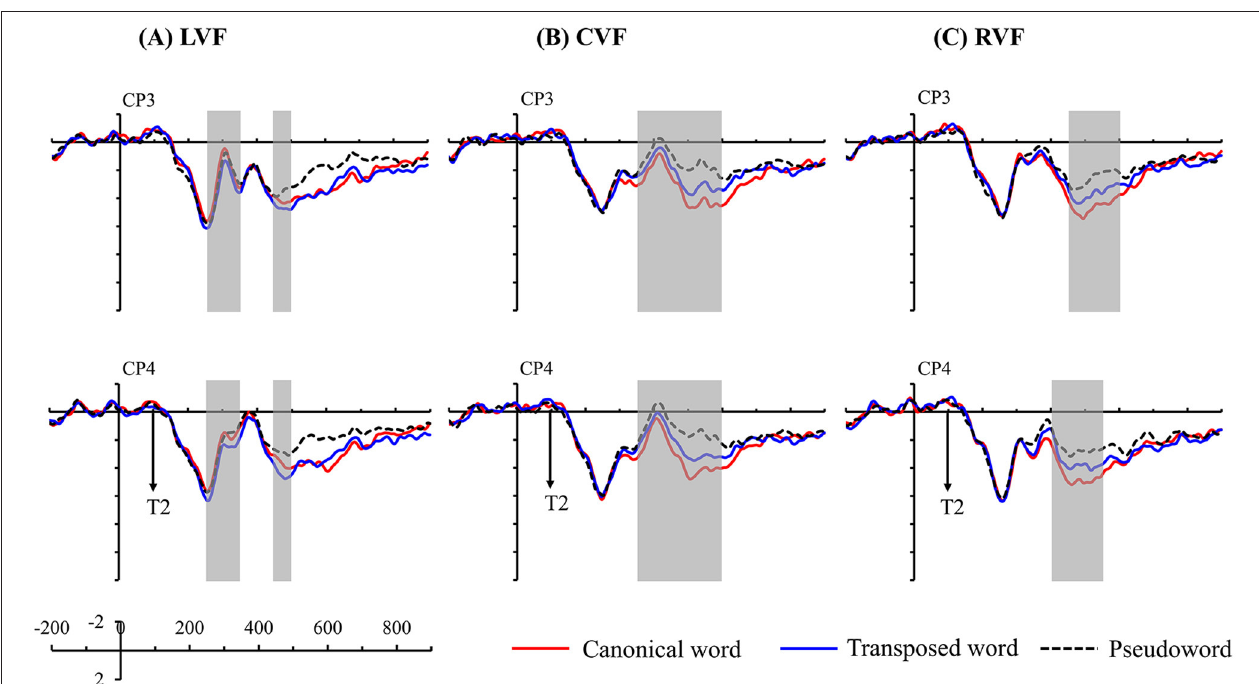
FIGURE 3 | Average ERP waveforms in CP3 and CP4 under three conditions: (A) left visual field (LVF) presentation, (B) centrally presented visual field (CVF), and (C) right visual field (RVF) presentation. The gray rectangles indicate significant ERP differences between canonical words and transposed words at the left and right posterior sites.